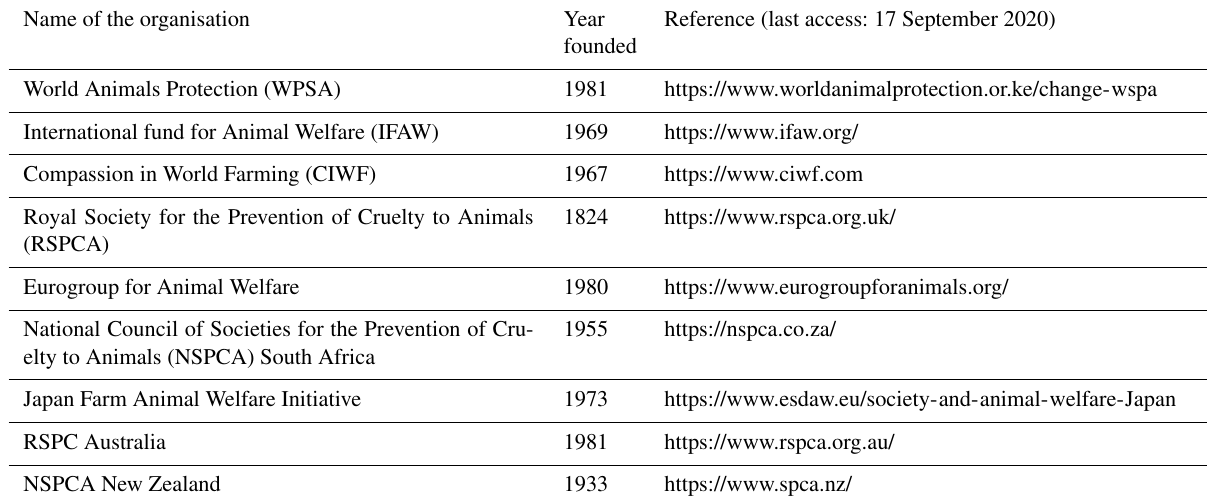
Table 2. Examples of non-governmental animal welfare organisations around the world and the years in which they were founded. Name of the